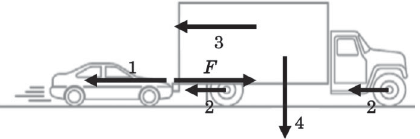
FIG. 3 (color online). Subquestions of FCI Q.16.